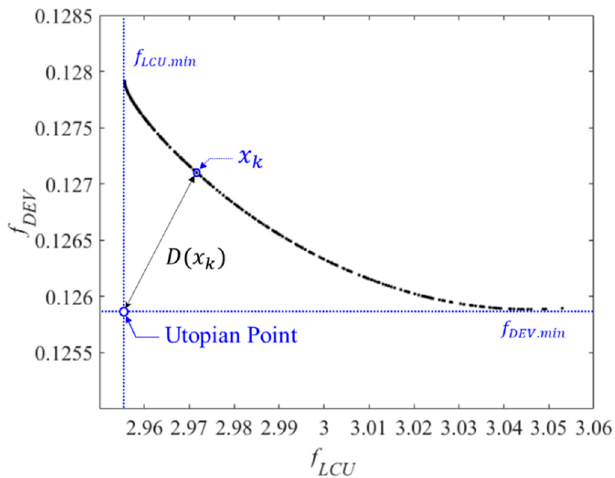
Figure 7. Pareto optimal front (POF) of the multi-objective function.